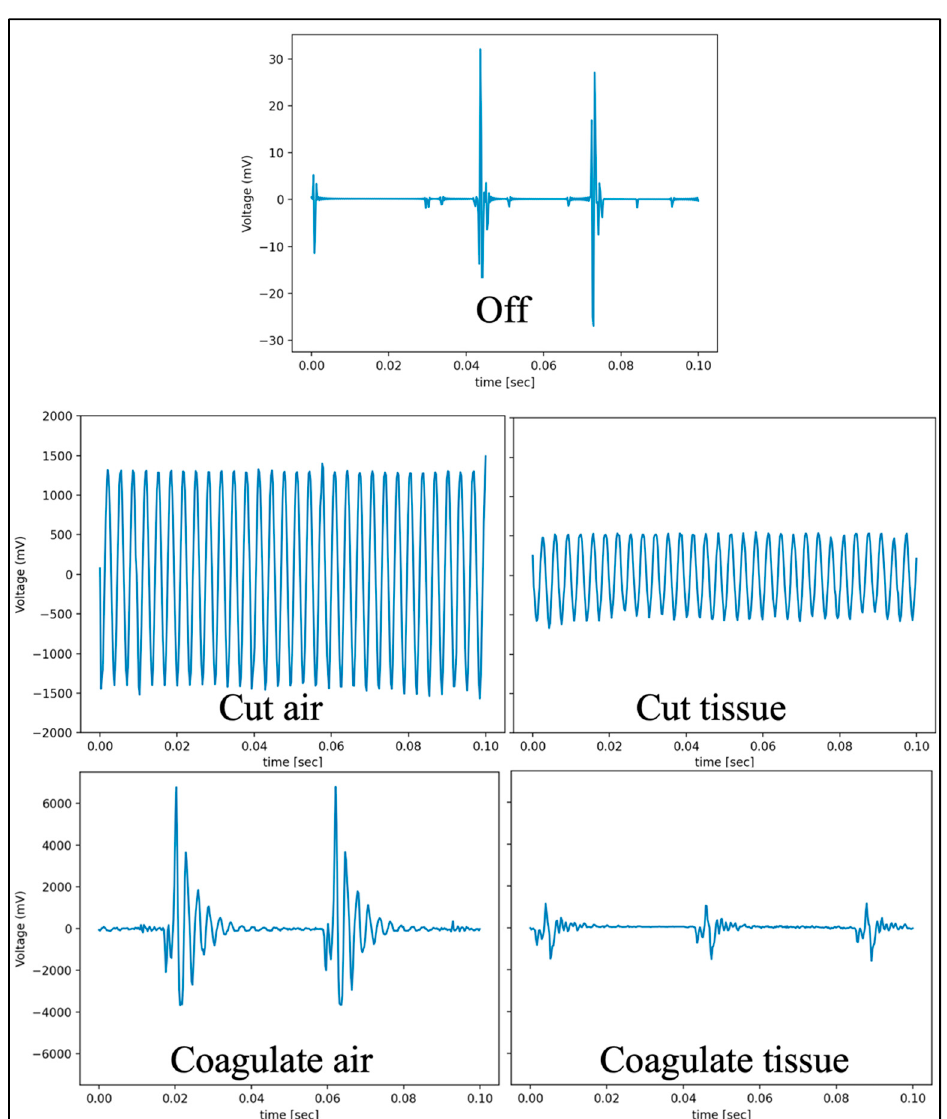
Figure 4. Current samples from the live cautery wire for each cautery state on the Valley Lab ESU. The voltage patterns and values measured for each cautery mode differed significantly.